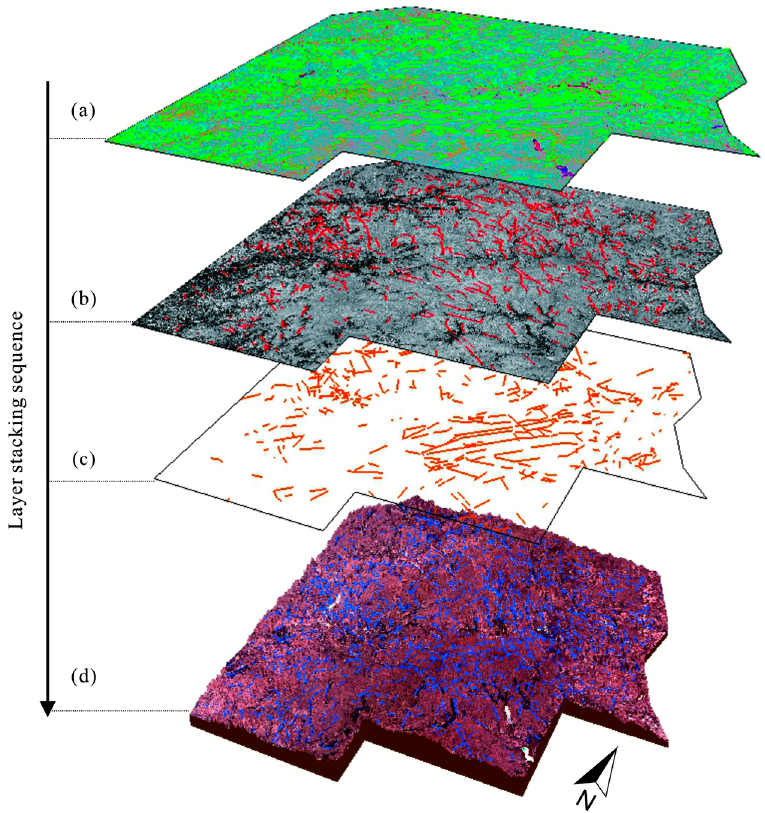
Figure 4. Linear structures superposition synthesis. ( a ) Extracting NE-SW directional filtering linear structure of remote sensing image; ( b ) Extracting NW-SE directional filtering linear structure of remote sensing image; ( c ) 1:250,000 scale geological map linear structure; ( d ) Synthesize all linear structure.